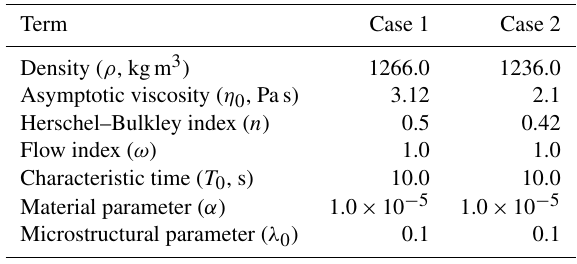
Table 6. Parameters of the time-dependent fluid model.